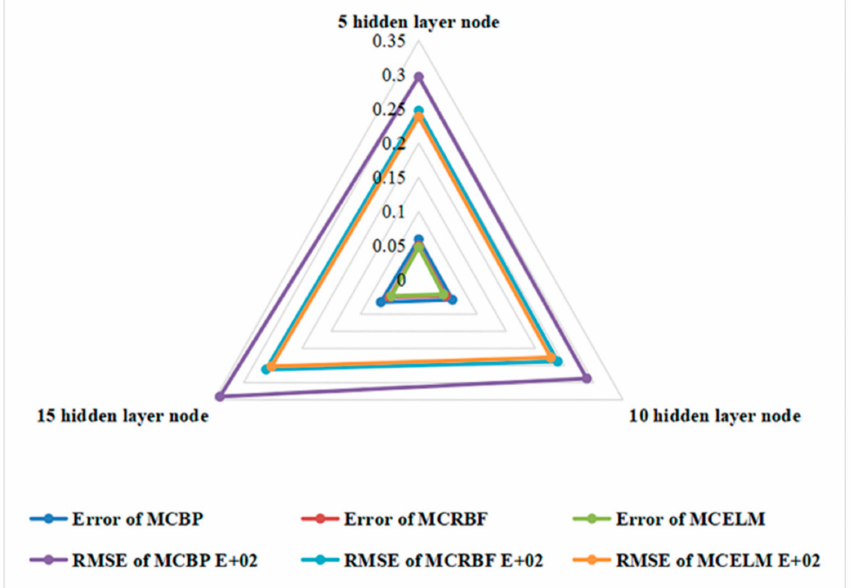
Figure 9. Comparisons of overall Error and root mean squared error (RMSE).